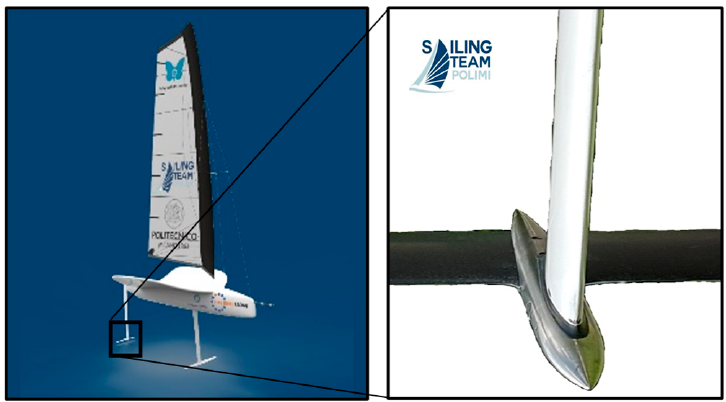
Figure 1. PoliMi Sailing Team rudder bulb concept model, from the team’s archive.